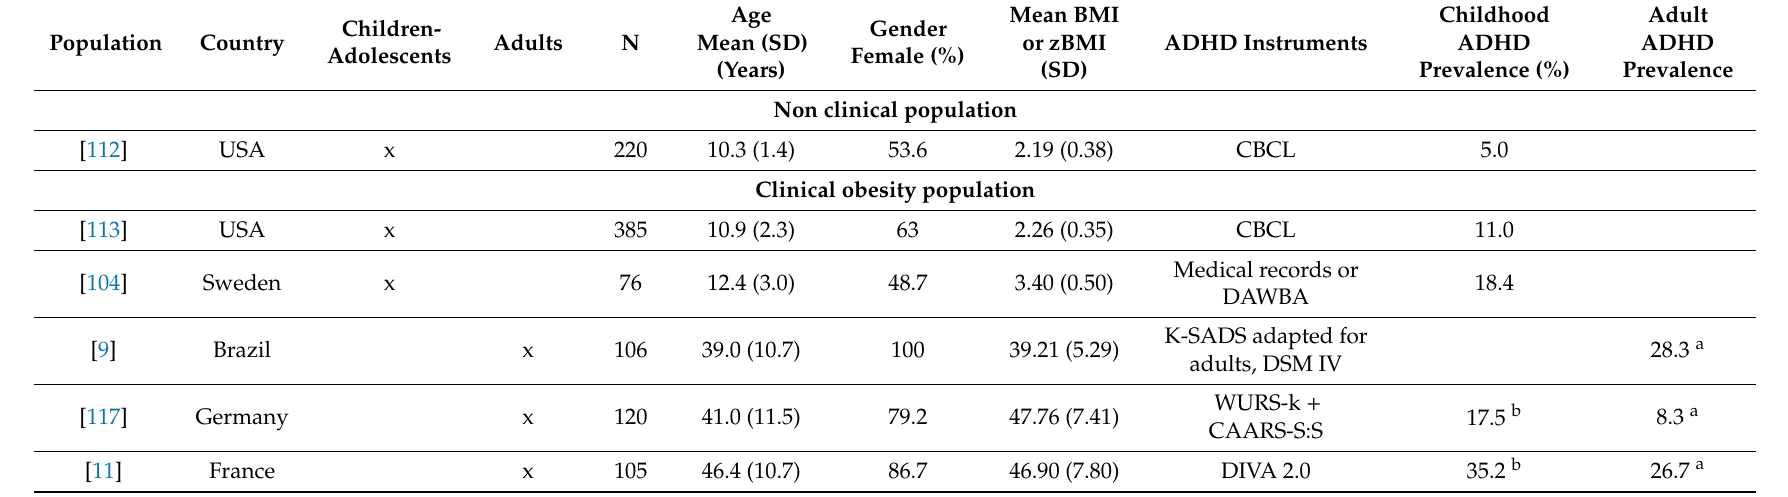
Table 3. Attention-Deficit Hyperactivity Disorder prevalence among population with overweight or obesity. Children- Population Country